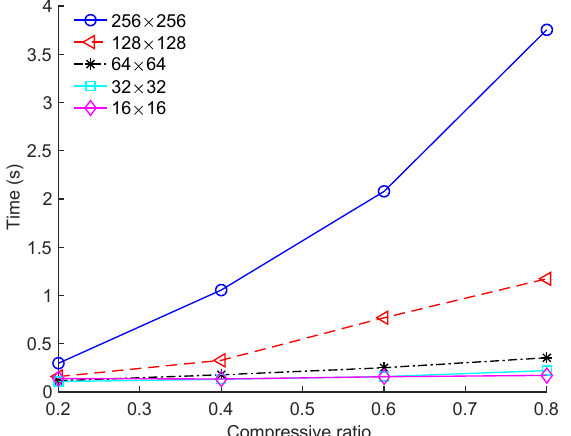
Figure 6. Run times of image-based BCS under different block sizes on the “House” image.